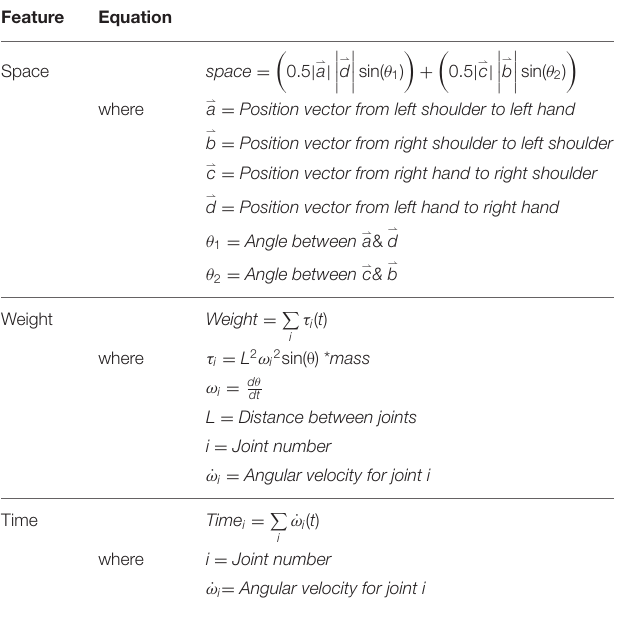
TABLE 1 | Equations for the derived Laban features adopted from Masuda et al. (2009) and Wakayama et al. (2010). Feature